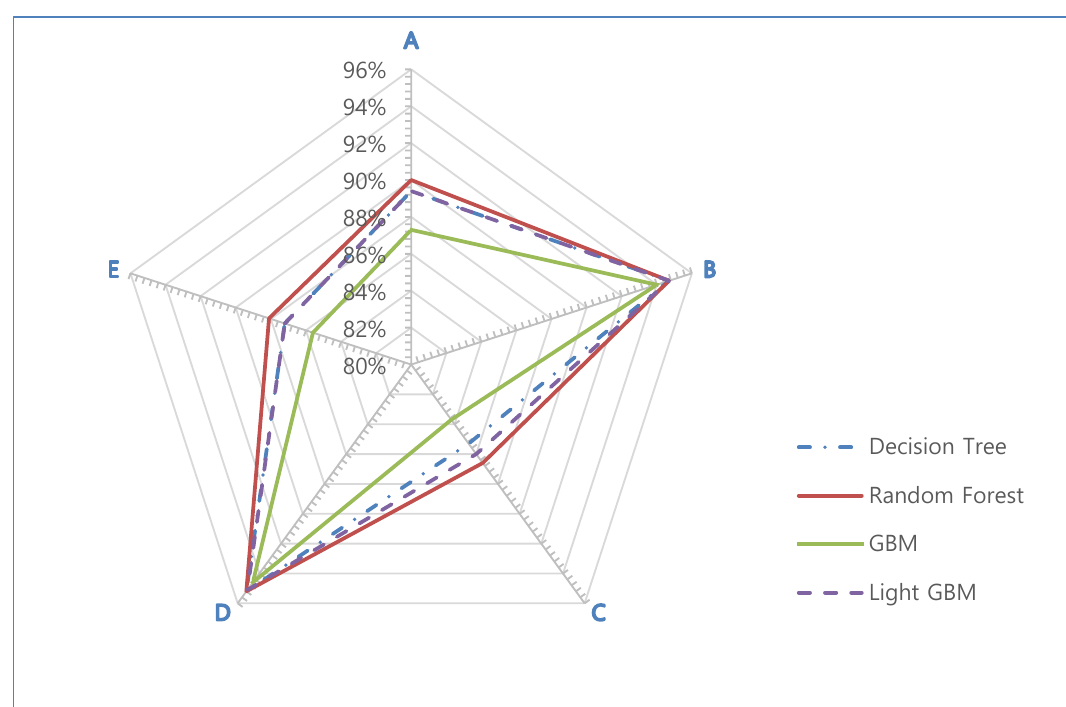
Figure 3. The accuracy of ML-analysis model developed for distinguishing the actual weights by classification algorithms.